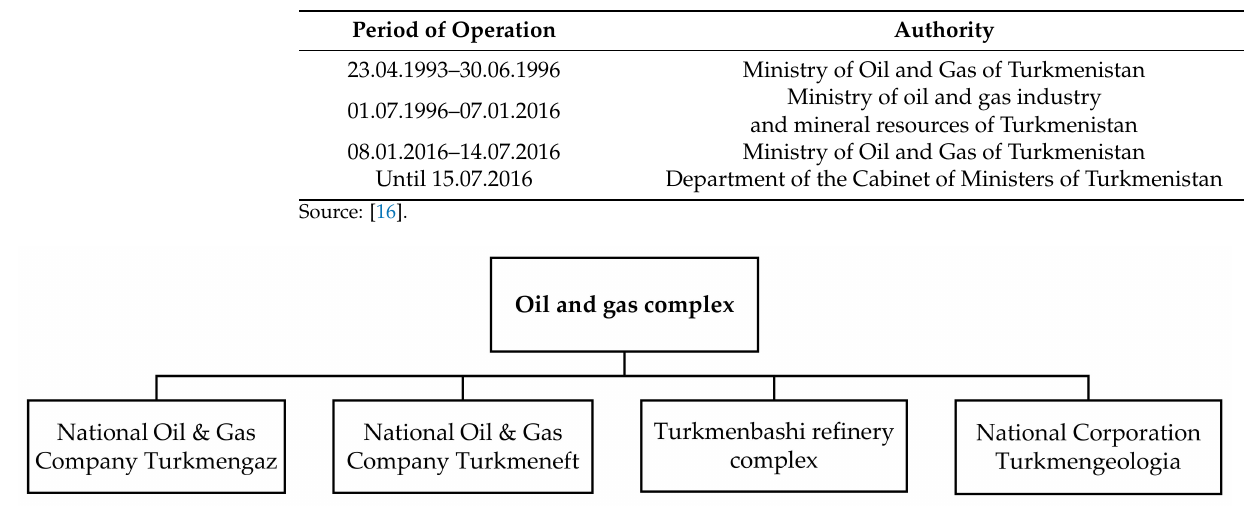
Table 2. Turkmenistan’s governing bodies responsible for the oil and gas complex.